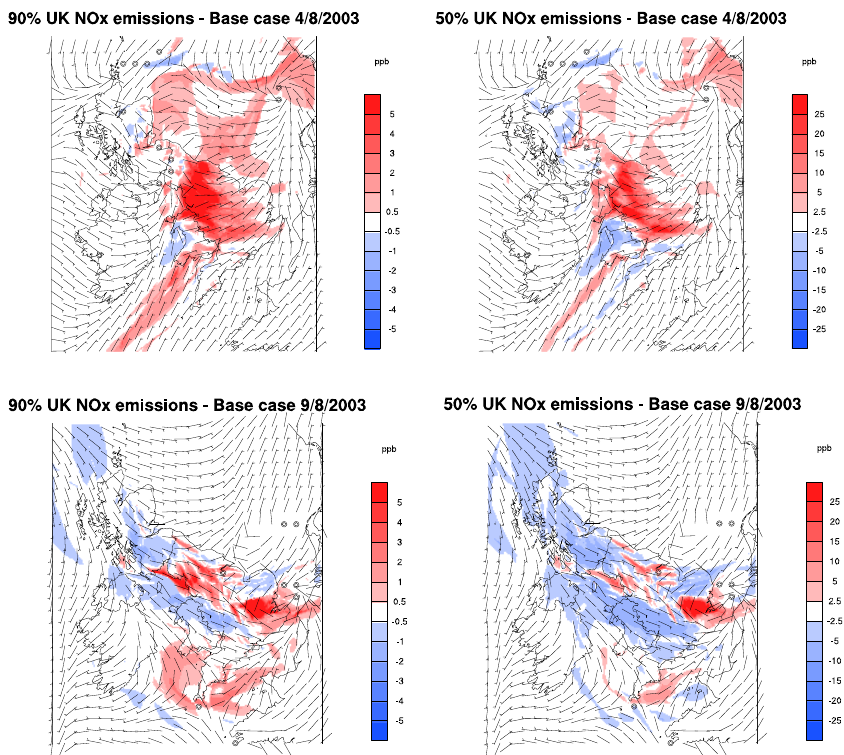
Figure 14: Change in simulated surface daily maximum ozone (ppb) relative to the base case scenario for the sensitivity experiment with 10% (left) and 50% (right) reduction of the UK anthropogenic NO x emissions, for two days, 4 th (upper panels) and 9 th August (lower panels). The 12:00 10 m wind is also shown.